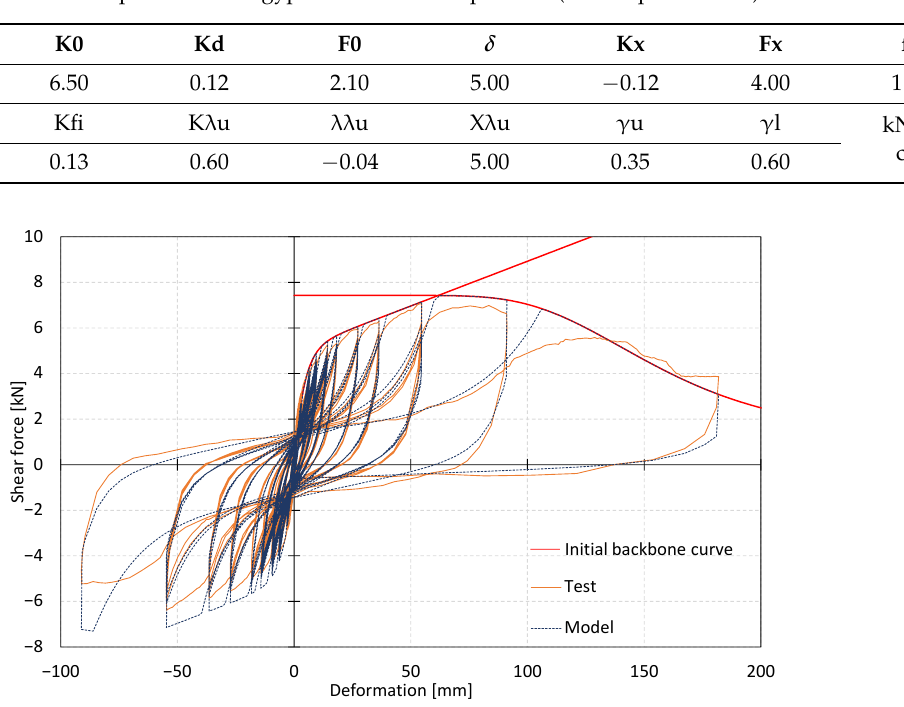
Table 2. Set parameters of plywood walls per wall. Table 3. Set parameters of gypsum board walls per wall (GN40 specification).